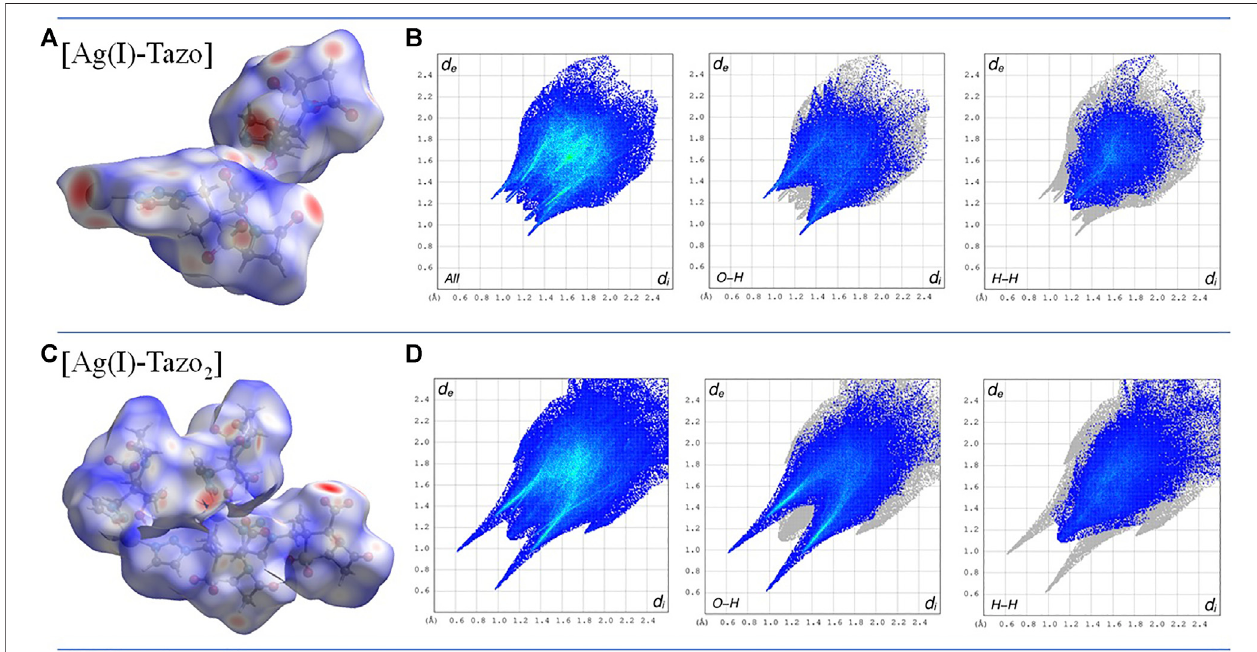
FIGURE 8 | Hirshfeld surface mapped with d norm , with surfaces shown as transparent to allow the visualization of the compound (A) and two-dimensional fi ngerprint plots (B) for the most relevant interactions in [Ag(I)-Tazo] (C) and [Ag(I)-Tazo